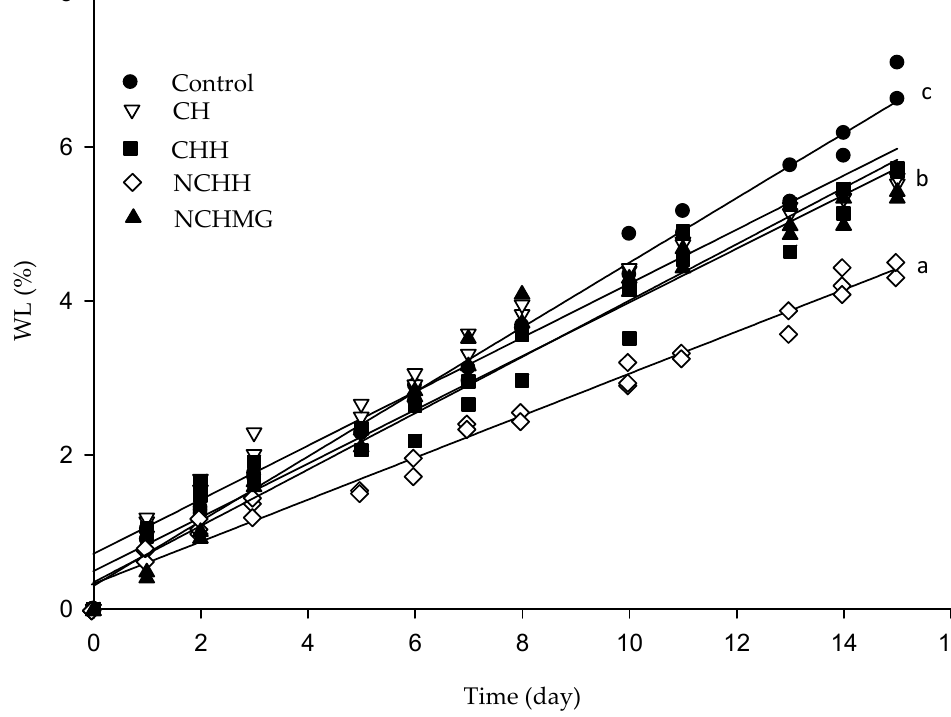
Figure 1. Weight Loss (WL) of pitaya ( S. pruinosus ) ( n = 9) during storage at 10 °C and relative humidity (RH) of 80 % (See Table 2 for treatment identification). Different letters among traces mean significant differences ( p < 0.05).